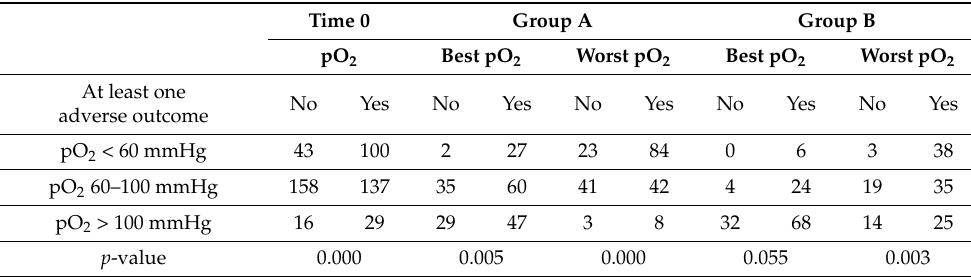
Table 4. Number of patients based on PaO2 values at time 0, in Group A and Group B, divided into those with and without at least one adverse outcome.